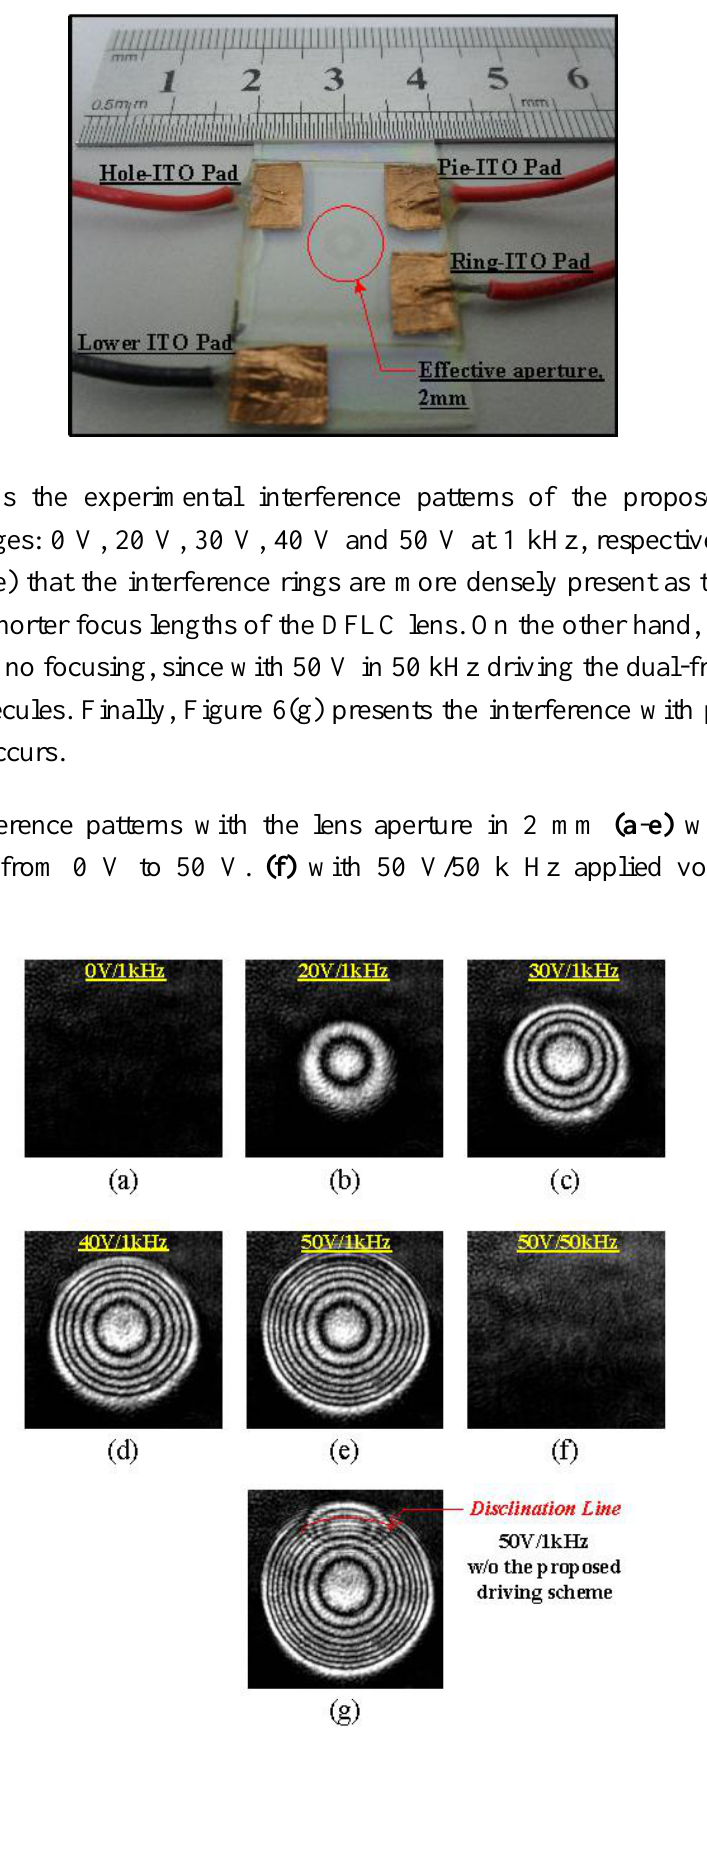
Figure 5. The photo of the proposed ring-and-pie DFLC